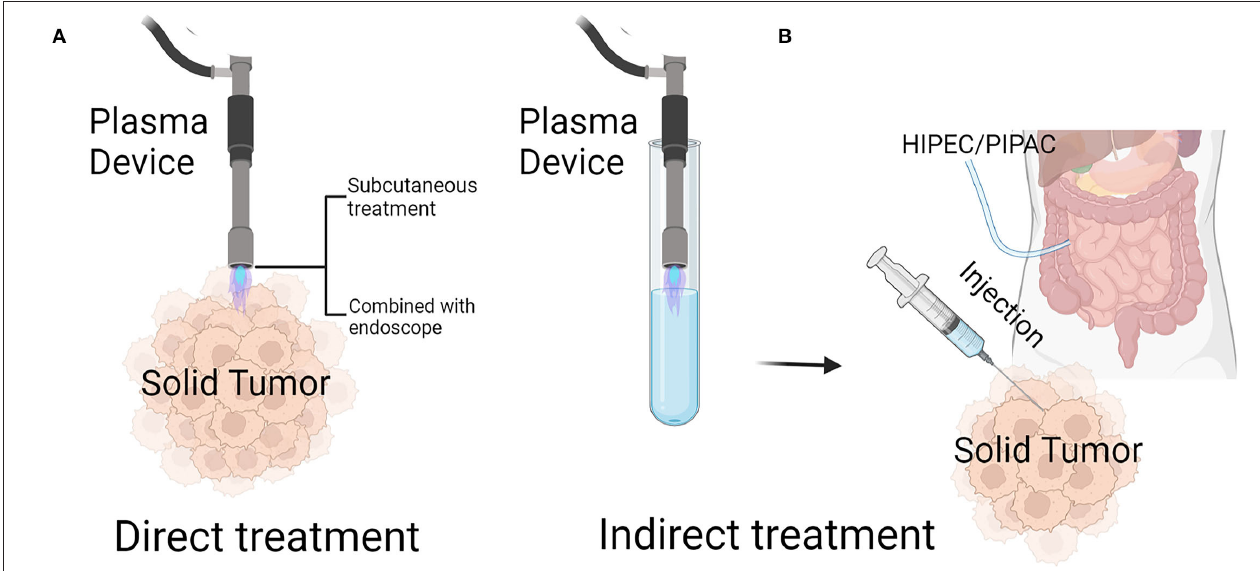
FIGURE 1 | Treatment of solid tumors by cold atmospheric plasma (CAP). (A) Direct treatment of CAP can be done by spraying subcutaneous tumors through the skin, or in combination with endoscopes, by irradiating solid tumors through the digestive tract or abdominal cavity. (B) Indirect treatment of CAP: after activating a specific liquid with a CAP device, the plasma-activated liquid can be injected directly into solid tumors, or intraperitoneal perfusion can be carried out by HIPEC/PIPAC. HIPEC, Hyperthermic Intraperitoneal Chemotherapy; PIPAC, Pressurized Intraperitoneal Aerosol Chemotherapy. Created by